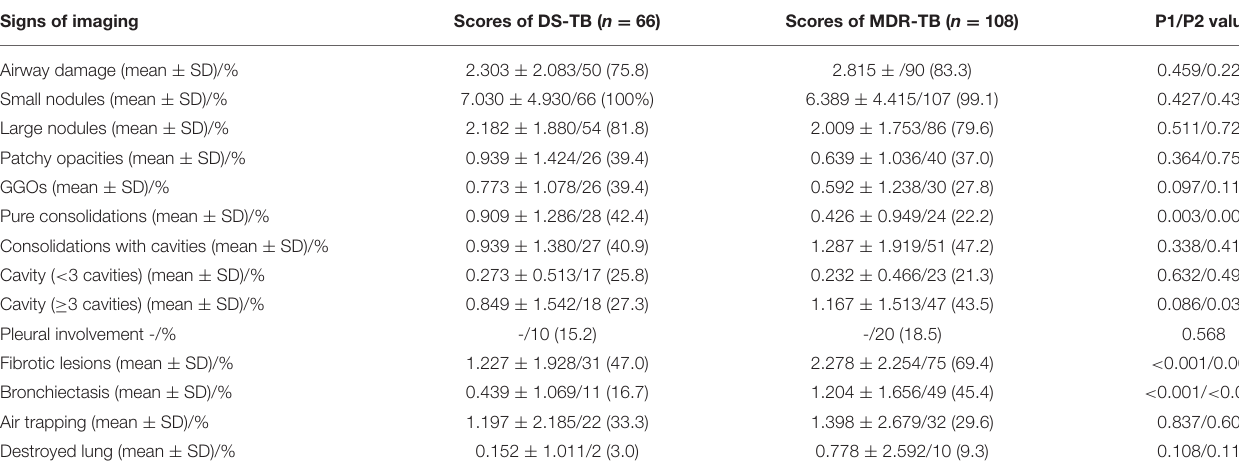
TABLE 2 | Comparison of imaging features in MDR-TB and DS-TB cases. Signs of